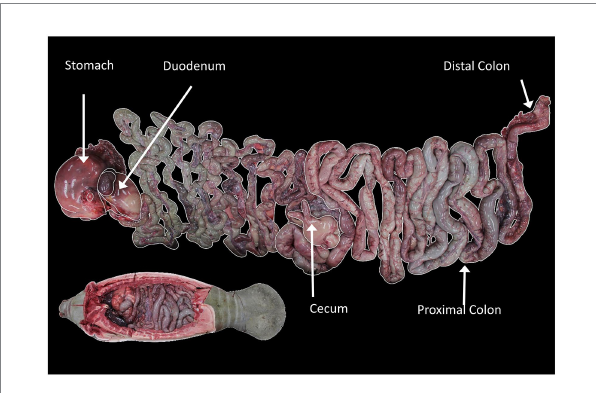
FIGURE 1 Location of sampling sites in the GI tract of the manatee. The lower inset image shows GI tract inside the manatee carcass in anatomical orientation, while the larger image shows the tract layed out. Image credit: Florida Fish and Wildlife Conservation